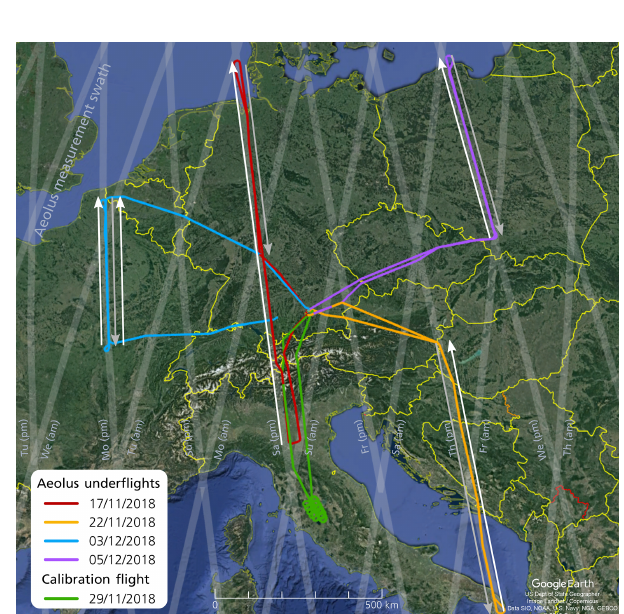
Figure 2. Flight tracks of the Falcon aircraft during the WindVal III campaign from 17 November to 5 December 2018 (background im- age: © 2018 Google). Each colour represents a single flight. The Aeolus measurement swath is shown in grey. The arrows indicate the Falcon flight direction along the swath on the different legs in (white arrows) and against (grey arrows) the satellite direction, which was always from south to north during the probed evening satellite ascending orbits. The A2D was not operated during the flight on 17 November